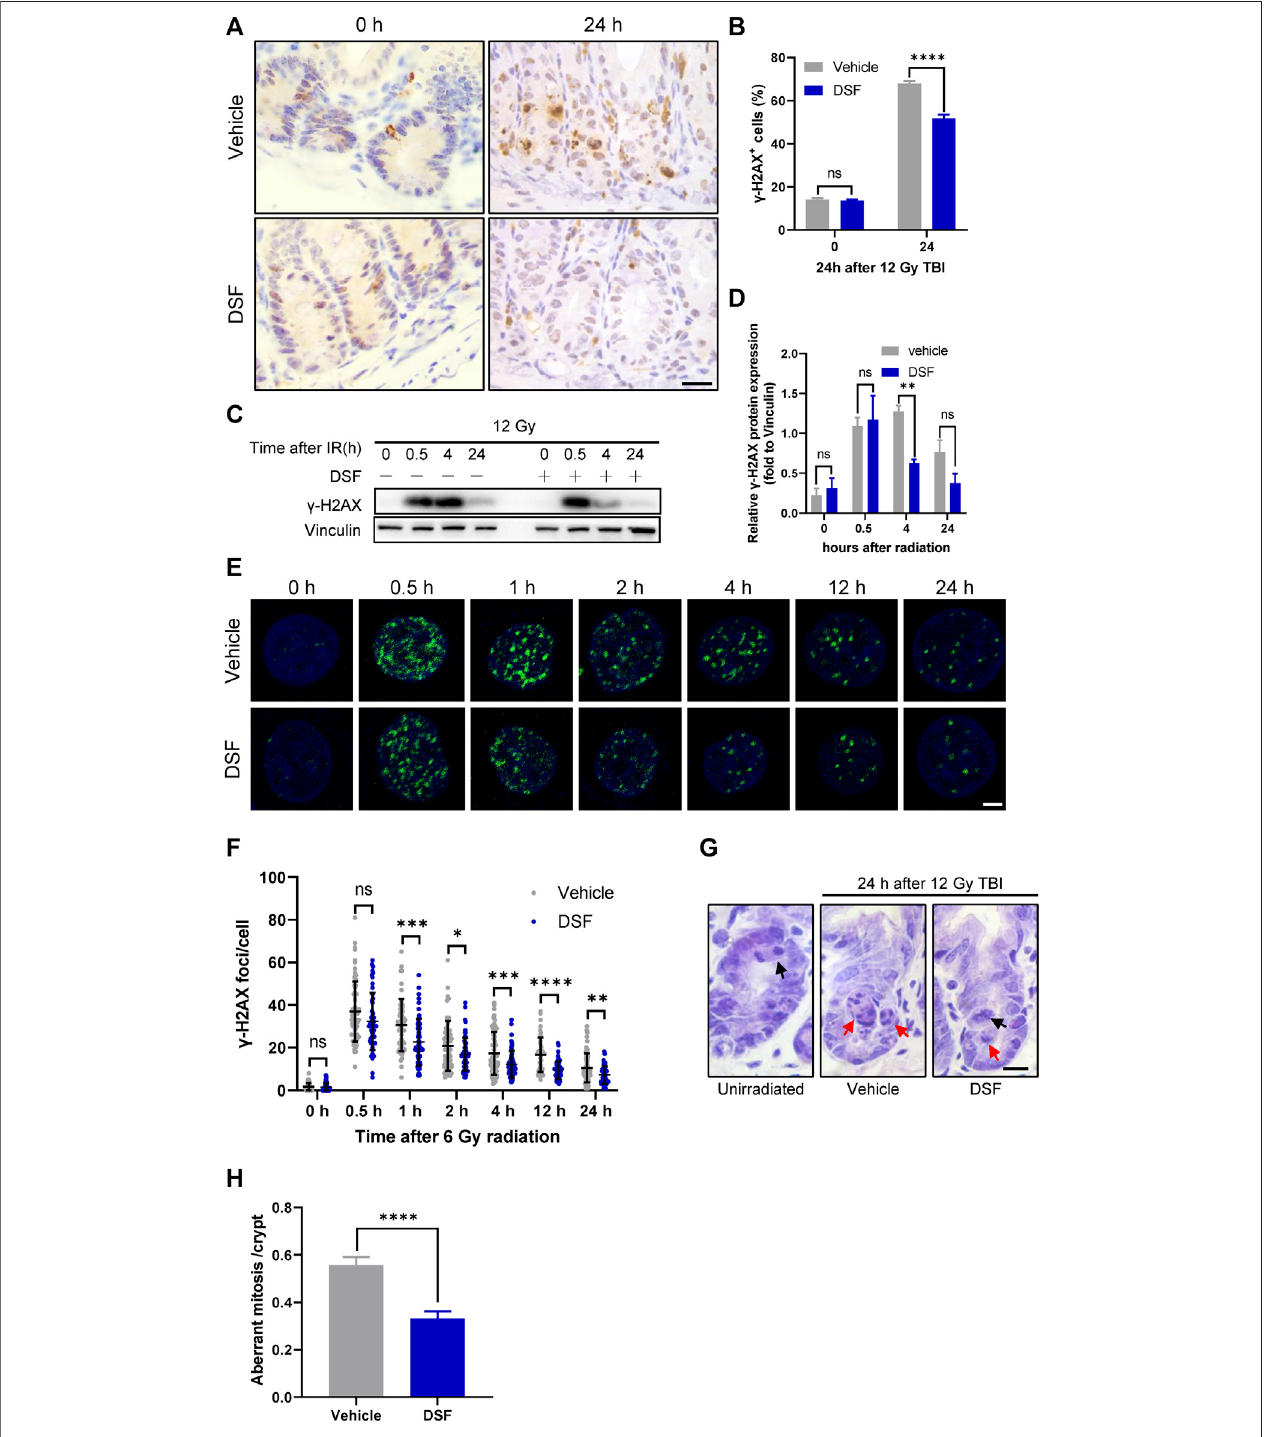
FIGURE5| DSF alleviatesDNAdamage accumulationand decreasesaberrant mitosis . Mice were intraperitoneal injected with100 mg/kg DSF or vehicle 1 h prior to 12 Gy irradiation. (A) Representative images of γ H2AX IHC at 0 and 24 h. Scale bar = 20 μ m. (B) Quantitative analysis of γ H2AX-positive crypt cells (%) in (A) . (C) Western blotting detection of γ H2AX protein expression of smallintestinal crypt cells. (D) The protein levels of γ H2AX were detected by western blot assays at indicated time points after radiation with vinculin as the internal control. (E) Representative IF images showing γ -H2AX foci in HIEC cells pretreated with or without 0.05 μ M DSF at indicated time points after 6 Gy radiation. γ H2AX foci are shown in green. Scale bar = 5 μ m. (F) Quantitative analysis of γ H2AX foci per cell. (G) Representative images of H&E-stained intestinal sections at 24 h after 12Gy radiation. Examples of normal and aberrant mitosis are indicated by black arrows and red arrows respectively. Scale bar = 10 μ m. (H) Quantitative analysis of aberrant mitoses per crypts in (F) . Values are means ± SEM; n = 3-4 mice in each group. * p < 0.05, ** p < 0.05, **** p < 0.0001 and **** p < 0.0001, vehicle versus DSF treatment, by unpaired, two-tailed Student ’ s t-test.